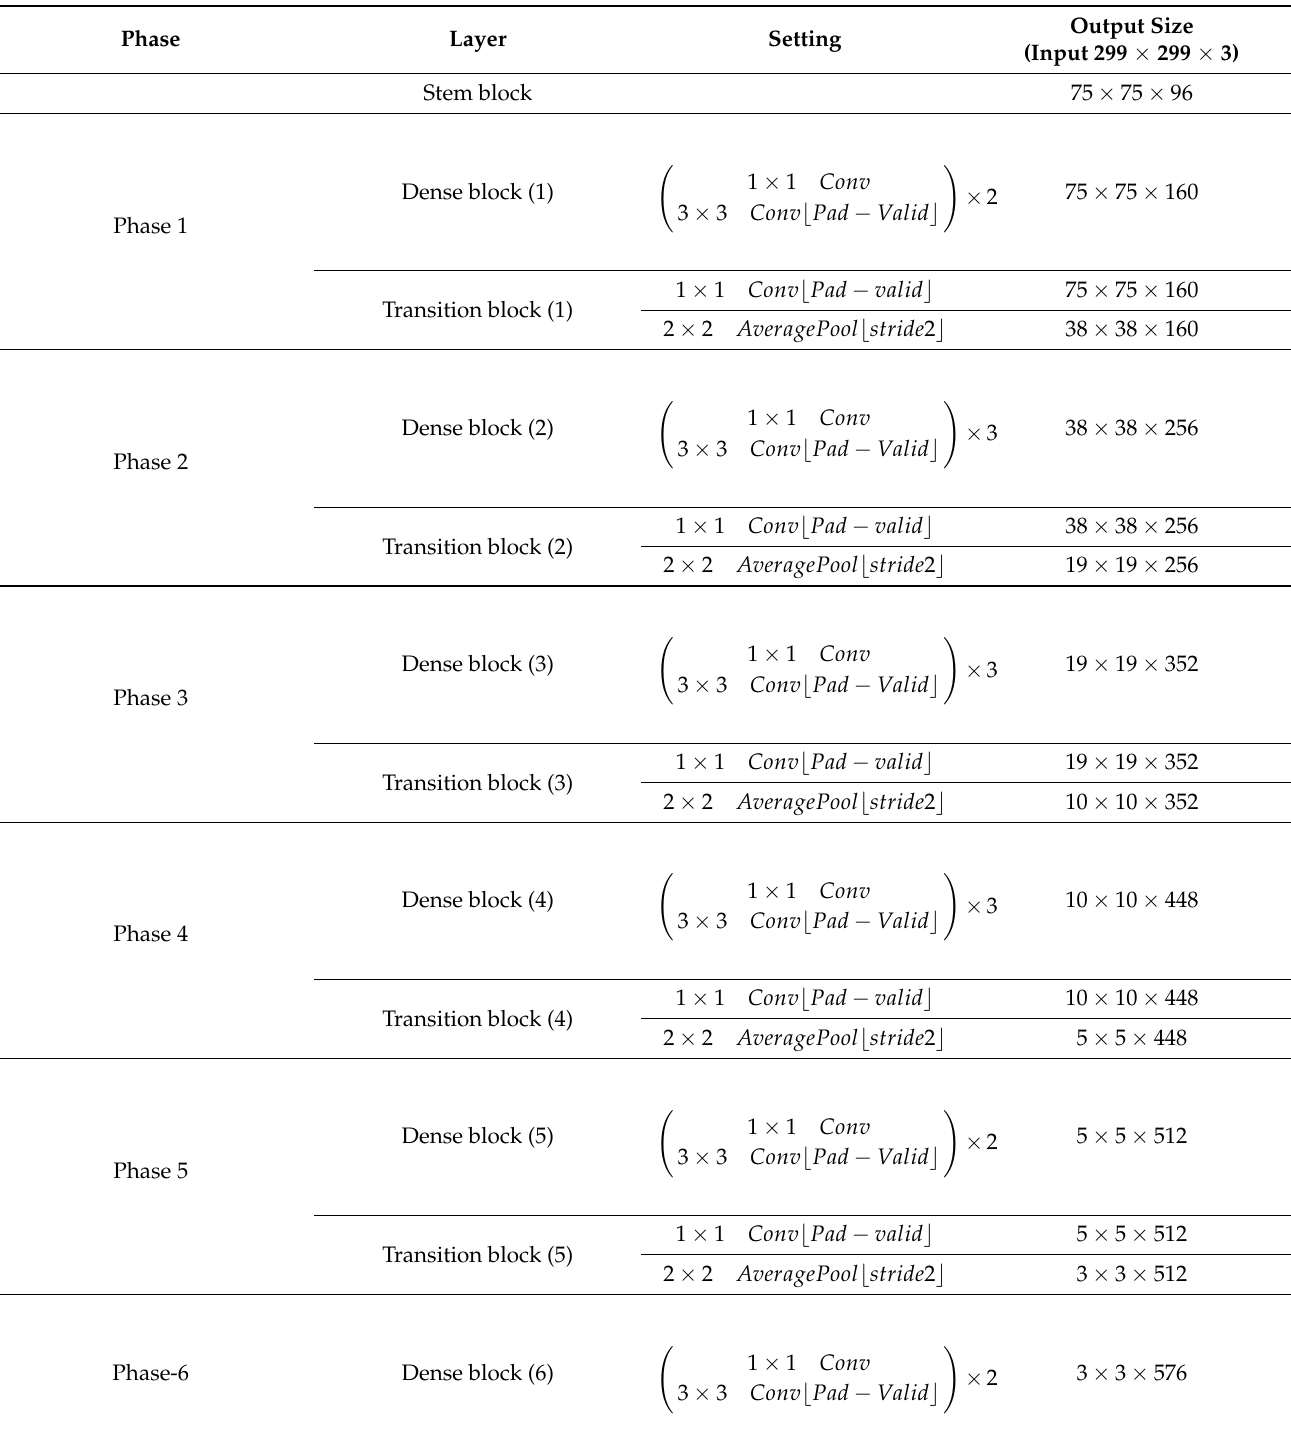
Table 1. Compact DenseNet-46 architecture (growth rate k = 32) in each dense